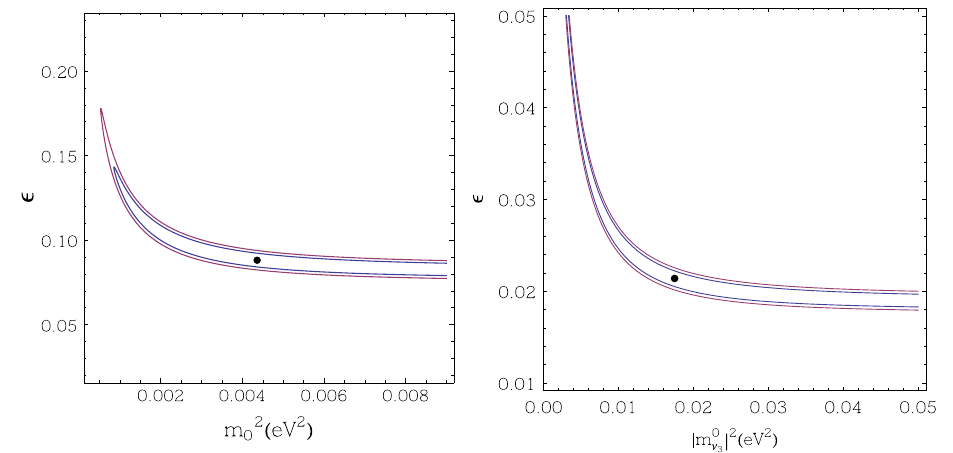
Fig. 4 Allowed regions in the m 0 – (cid:20) plane, at 90%CL (blue) and 95% CL (red) for degenerate (left) and inverted (right) hierarchy. Again, the θ ν parameter is fixed to the solar angle and the α Majorana phase is marginalized